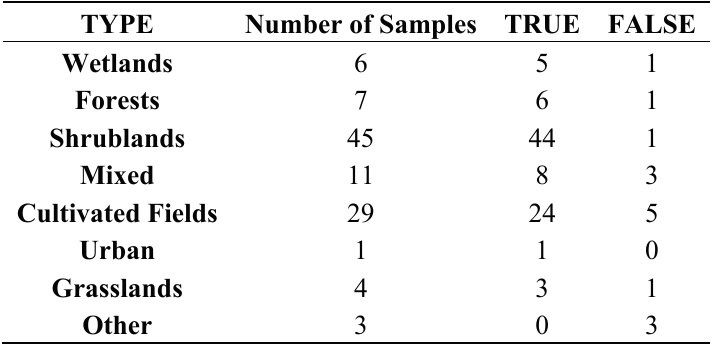
Table 3. Sampling for the validation of the